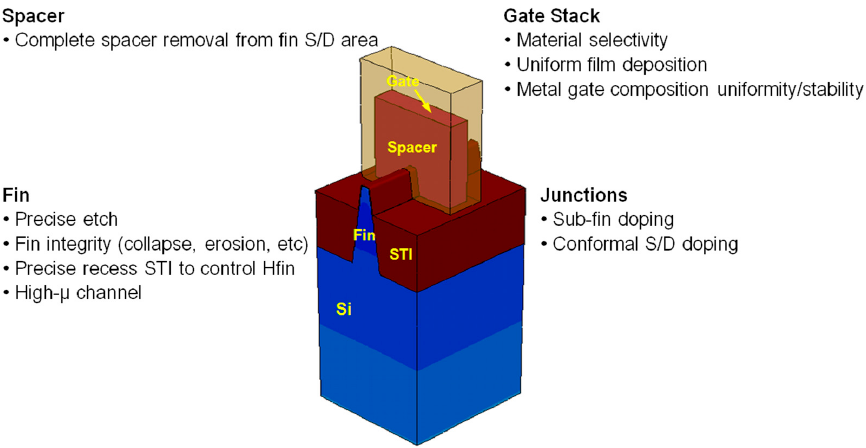
Figure 2. New challenges in fabrication of FinFETs.